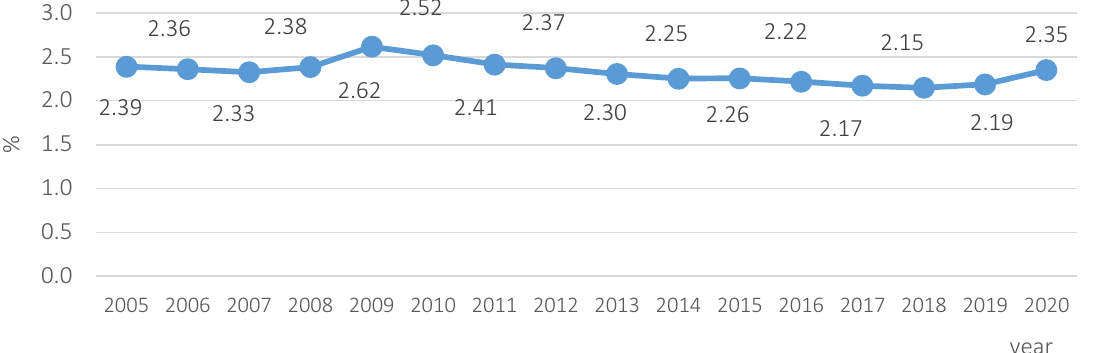
Figure 3. Military expenditure (% of GDP) in the world